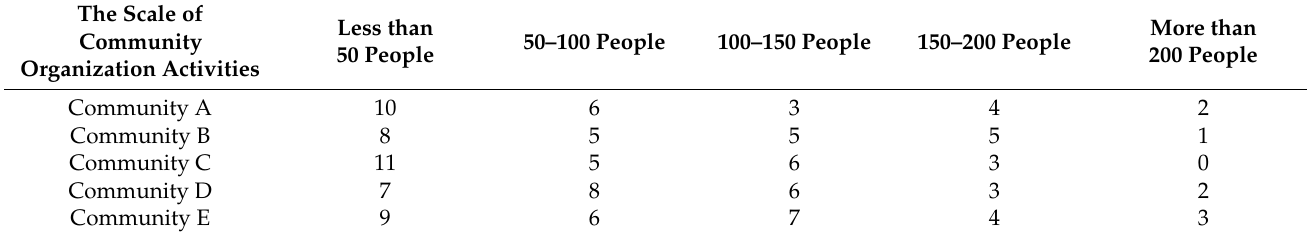
Table 2. Current status of supply of community public sports